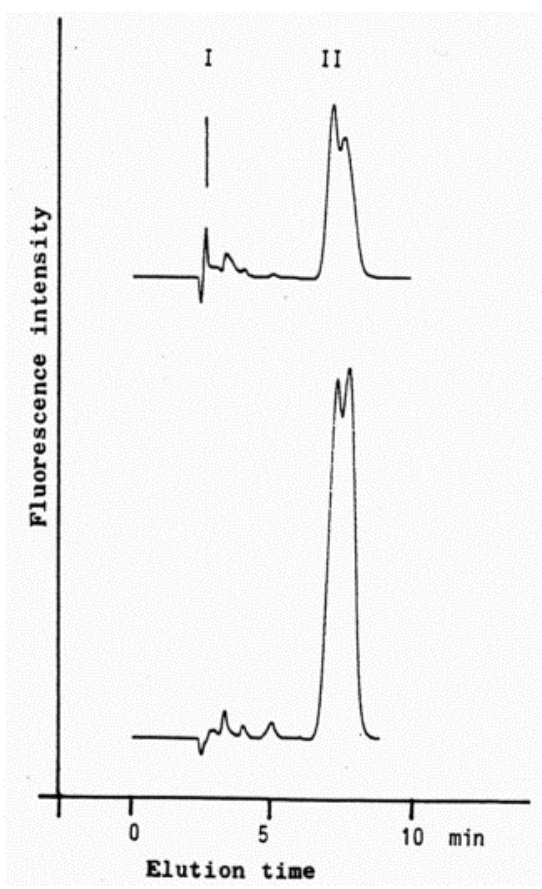
Figure 10. HPLC chromatogram of the isoindol derivative of the HNE-GSH conjugate (reaction product in presence of o-phthalaldehyde). Fluorimetric detection at 345 nm (excitation) and 445 nm (emission). Peaks: I GSH derivative; II HNE-GSH derivative; upper panel: Standard solution (45 µM); lower panel: extract from hepatocyte suspension incubated in presence of 100 µM 4-HNE